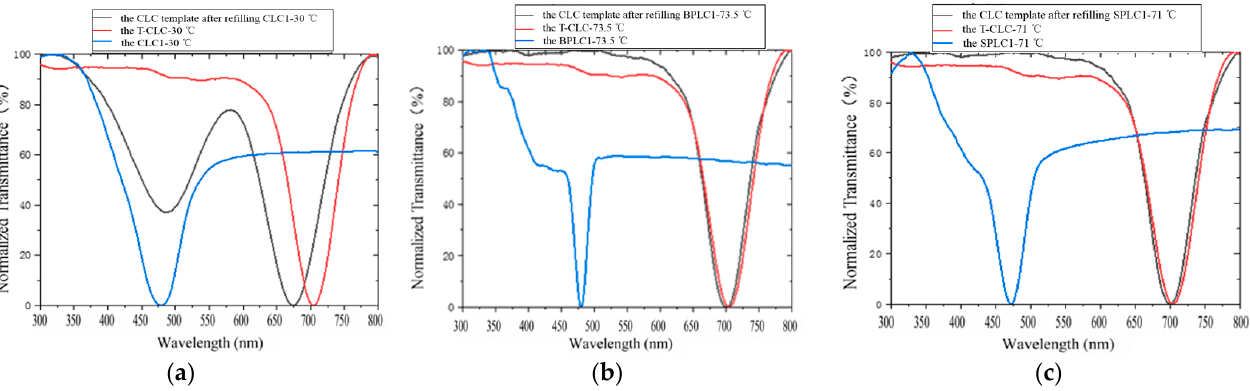
Figure 12. The reflection spectra of ( a ) CLC1, T-CLC, and the CLC template after refilling CLC1; ( b ) BPLC1, T-CLC, and the CLC template after refilling BPLC1; ( c ) SPLC1, T-CLC, and the CLC template after refilling SPLC1.